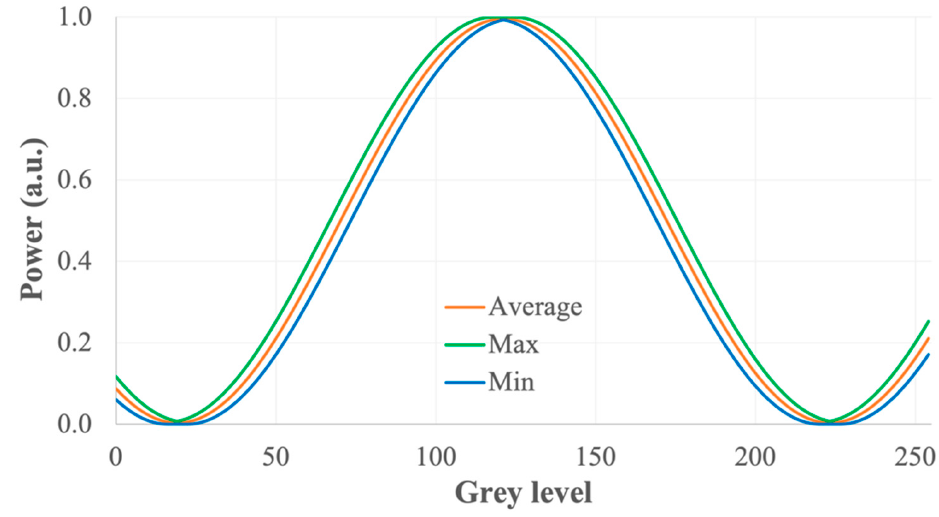
Figure 10. The simulated power response with an additional quarter waveplate.